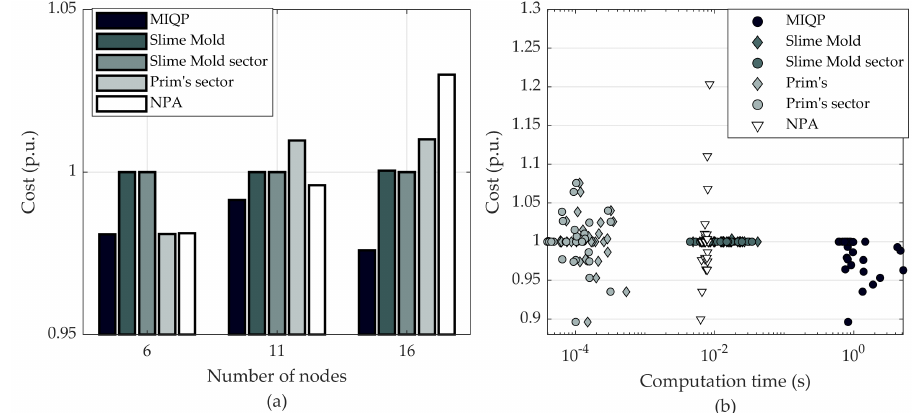
Figure 6. Average cost of rural networks ( a ), and the cost and the computation time of each network ( b